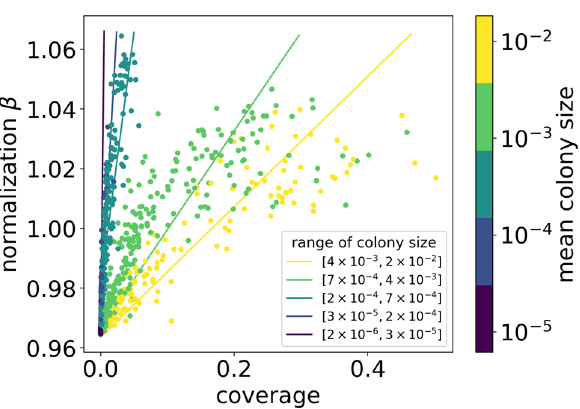
Figure 9. Dependence of β parameter on dish coverage, together with mean colony size indicated by the color of points. The points for different ranges of colony size (see the legend) cluster in subsets that show approximately linear dependence between β and coverage. Additionally, a linear function is fitted in each range, with a slope that decreases with colony size. Results obtained within MC dropout for the test